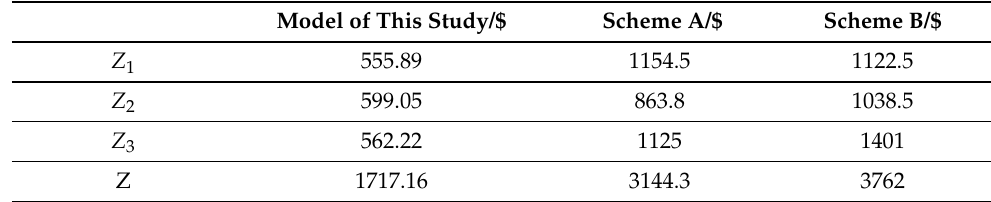
Table 3. The costs of utility